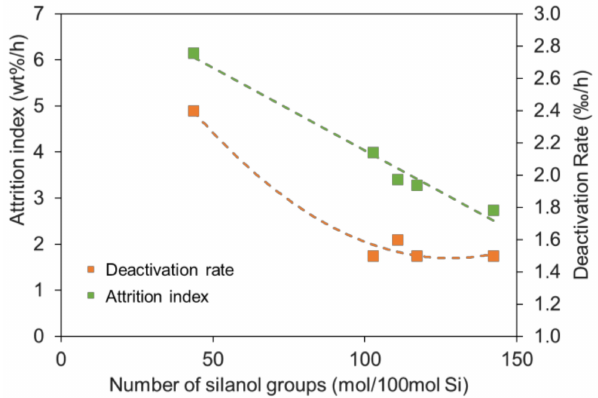
Figure 4. Attrition index and deactivation rate of as-prepared catalysts versus the number of silanol groups.